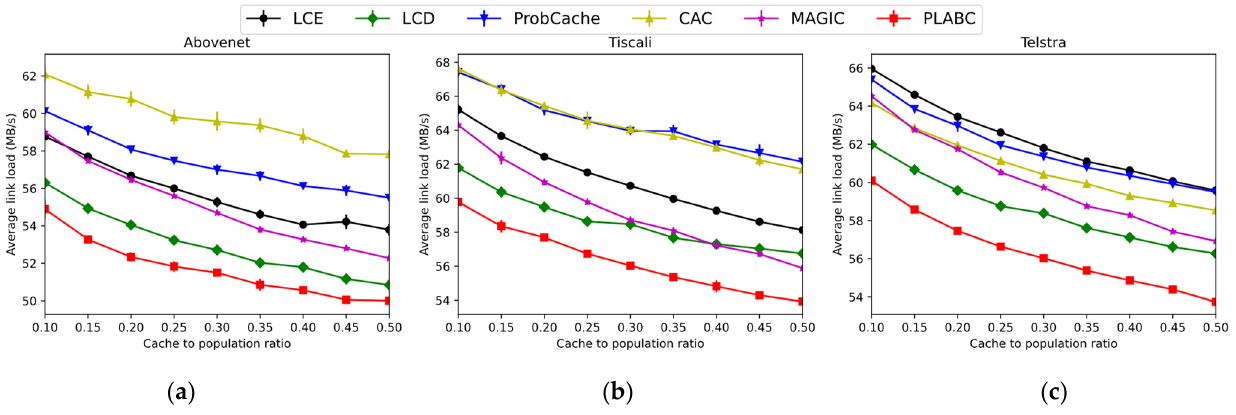
Figure 14. Average link load results of different caching strategies when the relative cache size varies under topology: ( a ) Abovenet; ( b ) Tiscali; ( c ) Telstra.